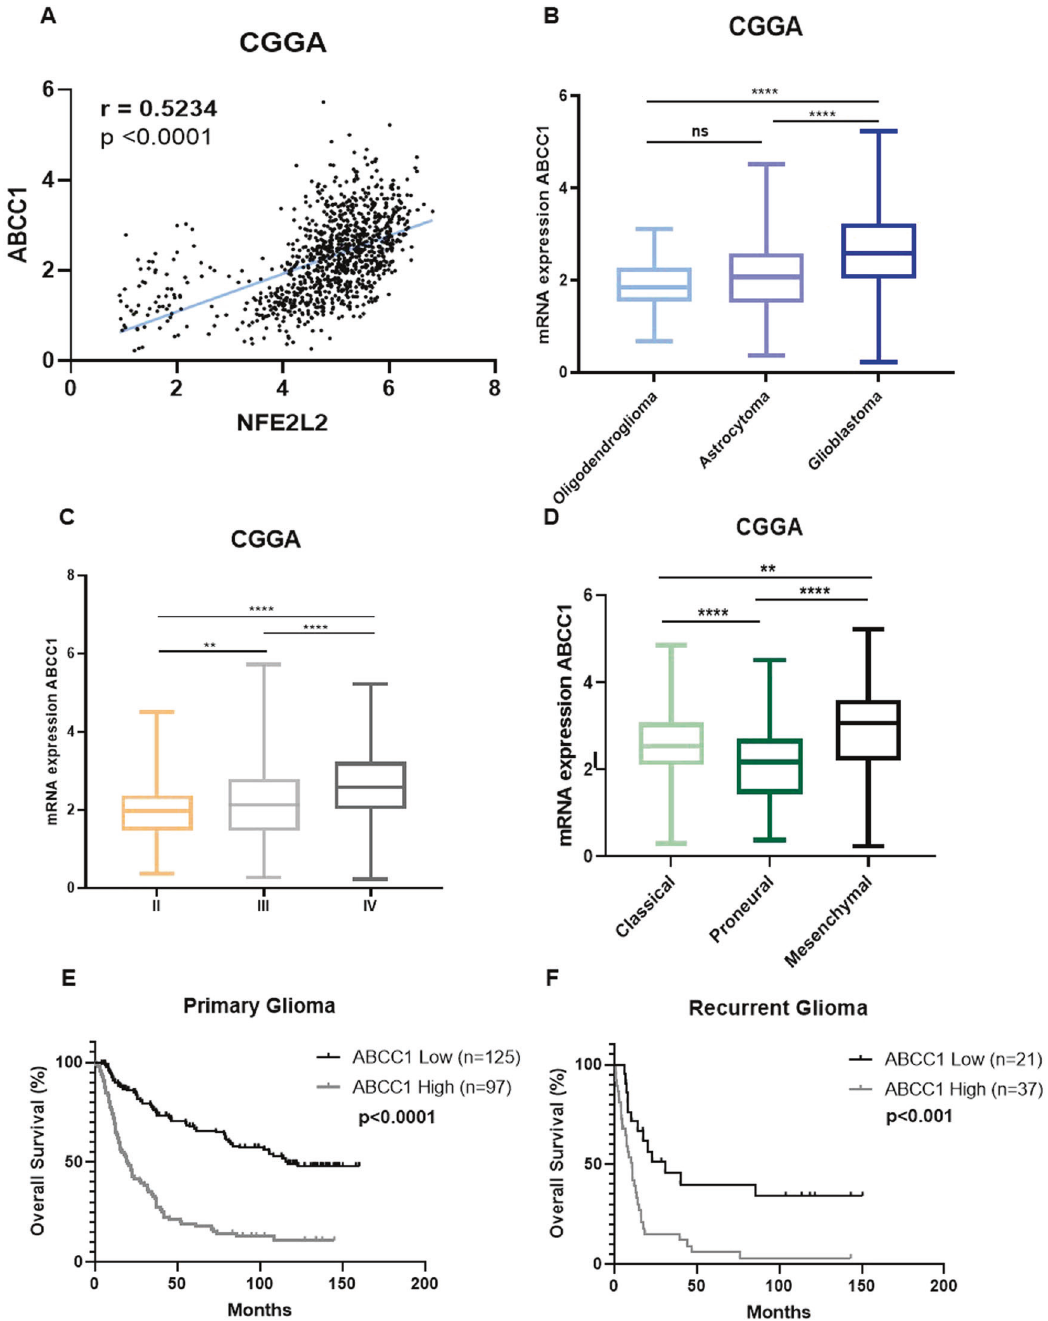
Fig. 6 Gene expression analysis of glioma patients. A Correlation between NRF2 and its target ABCC1 in glioma patients. B ABCC1 mRNA expression in the CGGA cohort of patients strati fi ed by histology; C grade; D and glioma subtype. E Kaplan – Meier curves showing overall survival of primary and F recurrent glioma patients from the CGGA cohort strati fi ed according to ABBC1 expression. Patients were subgrouped into high ABCC1 expression (above median) and low ABCC1 expression (below median). ns = not statistically signi fi cant, * P < 0.05, ** P < 0.01, *** P < 0.001, **** P <